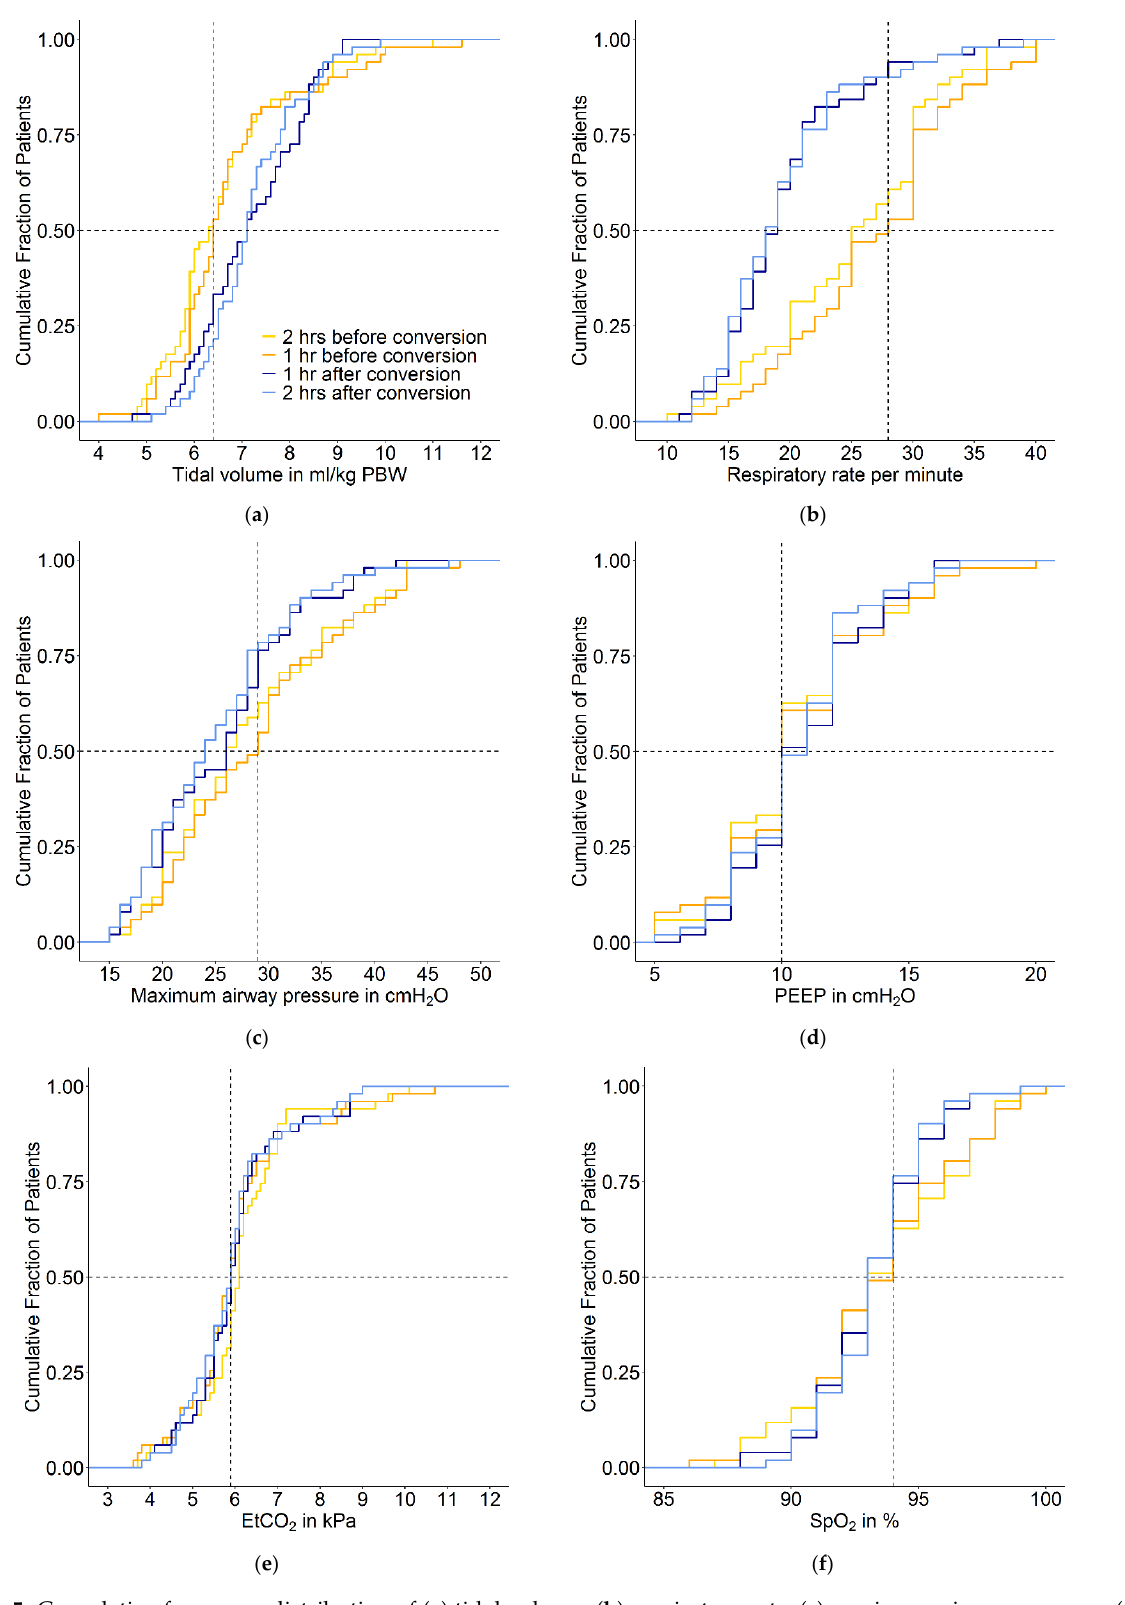
Figure 5. Cumulative frequency distribution of ( a ) tidal volume, ( b ) respiratory rate, ( c ) maximum airway pressure, ( d ) PEEP, ( e ) etCO 2 and ( f ) SpO 2 . The plots show the ventilation variables 2 and 1 h before the conversion and 1 and 2 h after the conversion from conventional ventilation to INTELLiVENT-ASV. Vertical dotted lines represent the median at the last hour before the conversion, and horizontal dotted lines show the respective proportion of patients reaching each cutoff. Table 3. Ventilation parameters at the predefined timepoints before and after the conversion from conventional ventilation to INTELLiVENT-ASV. Parameter